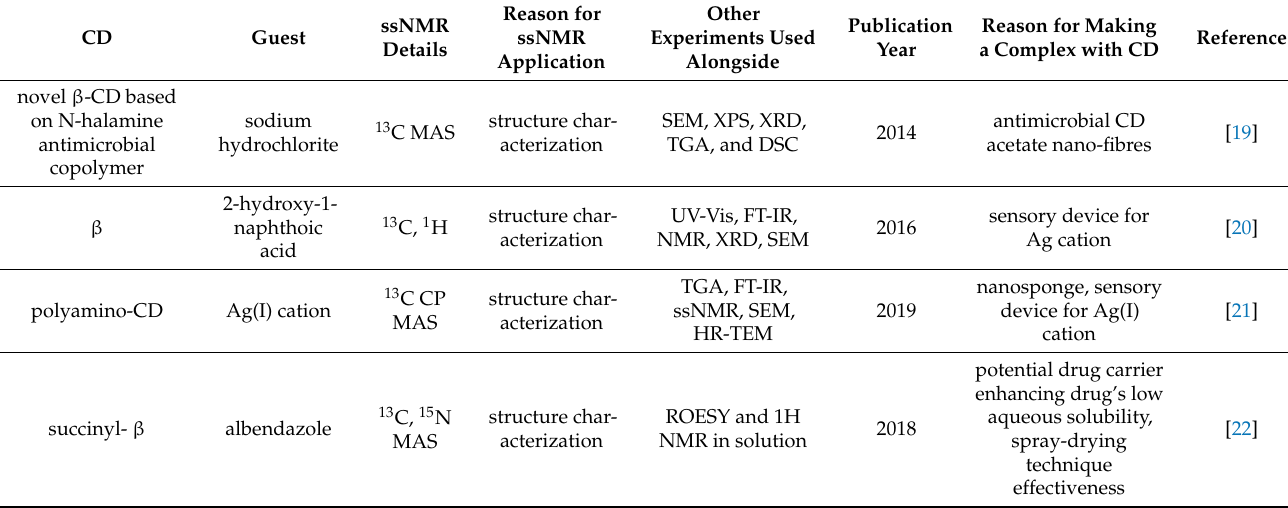
Table 1. General information regarding ssNMR application for the examination of the CD-including systems found in the articles published in period 2012–2022. Abbreviations used in the table: SEM (scanning electrine microscopy), XPS (X-ray photoelectron spectroscopy), XRD (X-ray diffraction), PXRD (Powder X-ray diffraction), TGA (thermogravimetric analysis), HR-TEM (high-resolution transmission electron microscopy), HPLC (high-performance liquid chromatography),